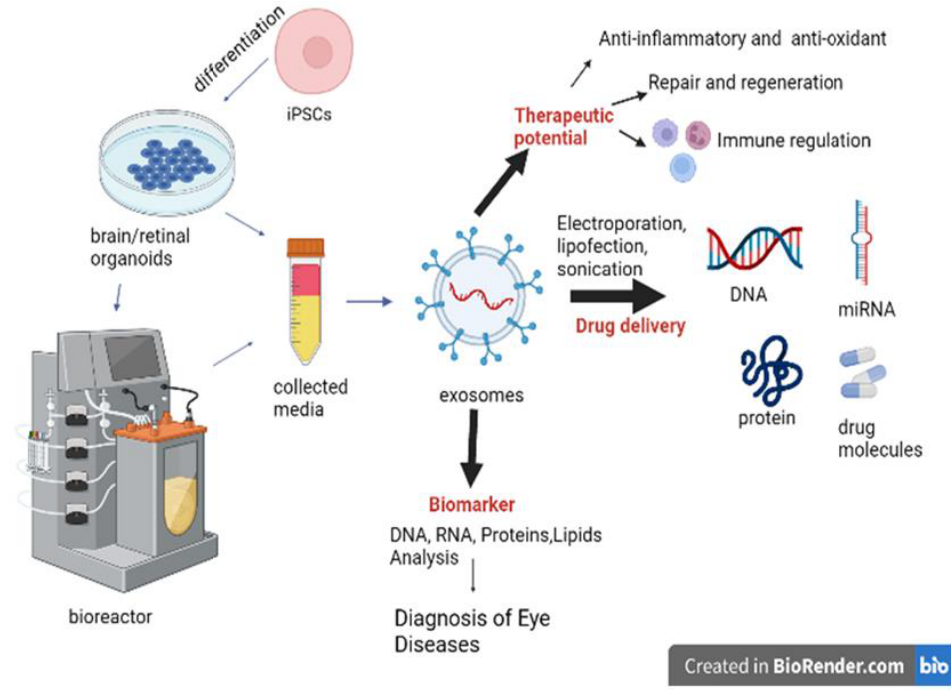
Figure 5. Schematic illustration of various applications of brain and retinal organoids and their derived exosomes in ocular diseases.